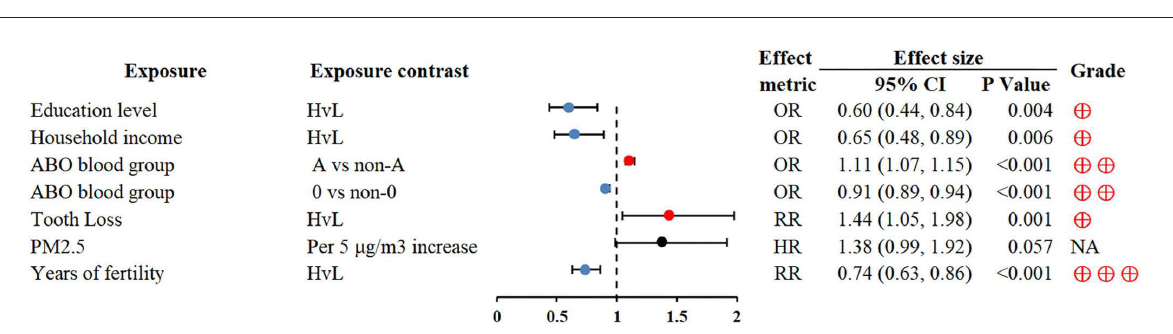
FIGURE9 Forest plot: summary effect estimates of meta-analyses reporting associations between GC and factors pertaining to other factors. PM2.5, particulate matter with a diameter of 2.5 µ m or less.